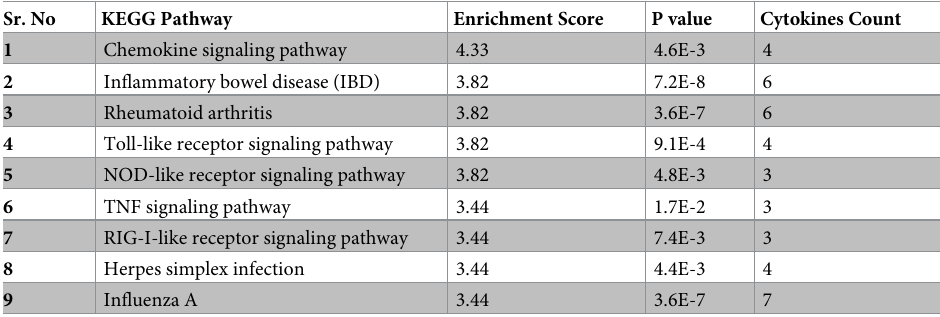
Table 6. KEGG analysis of 15 cytokine storm related